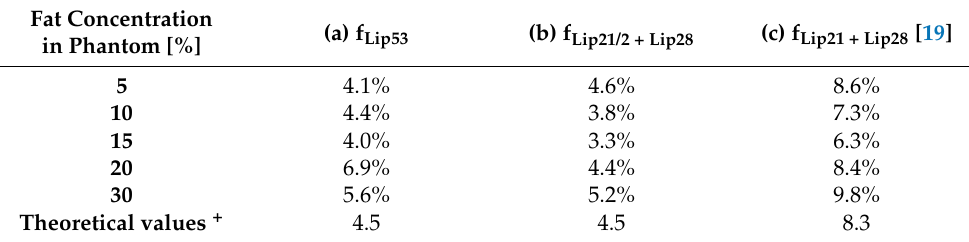
Table 5. Results of three methods for calculating unsaturated fraction f UI in the phantom according to Equation (4): (a) from signal intensities of olefinic protons (Lip53); (b) using modified Equation (4); (c) original equation from the literature